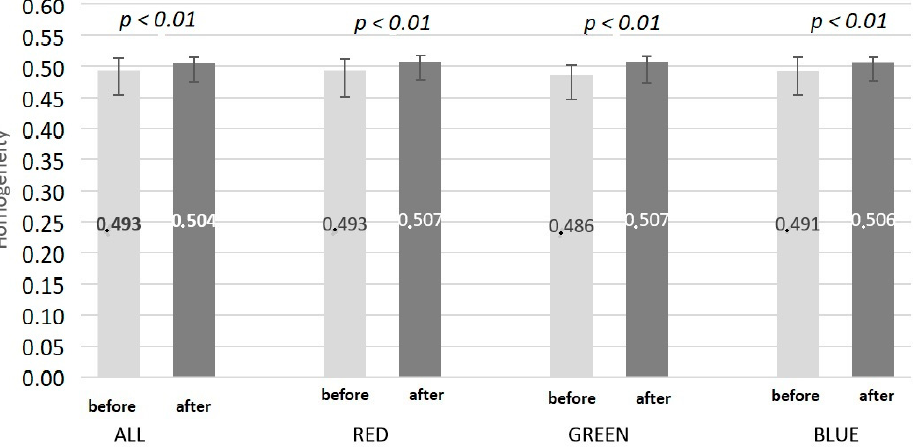
Figure 5. Average GLCM homogeneity of the treatment spot images in the full color range and in the red, green and blue channels after conversion to gray levels, in cross polarized light; before—before the first treatment; after—after third treatment.